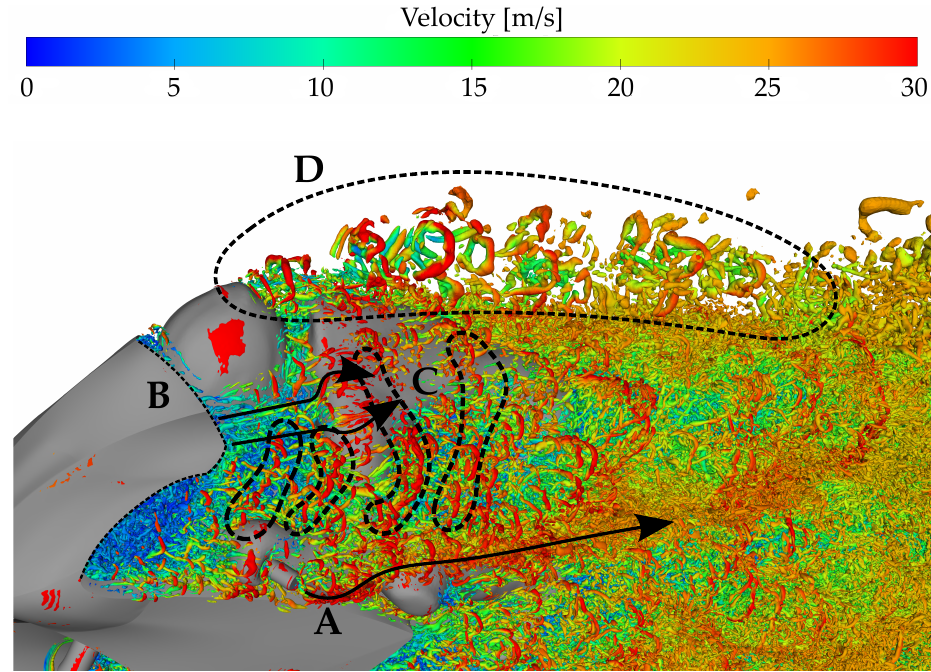
Figure 16. Isosurface of the normalised Q-criterion equal to 0.15 coloured by velocity values together with the characteristic zones ( A , B , C , D ) highlighted.